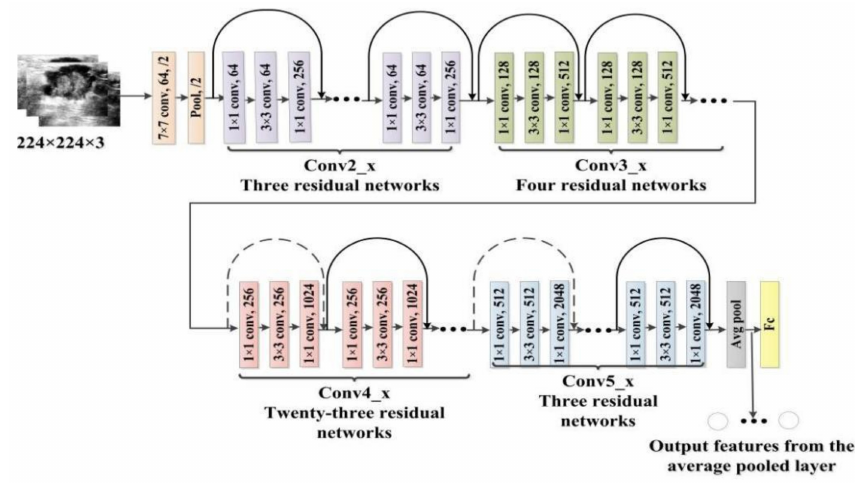
Figure 3. The extraction process of deep residual network features with pre-trained